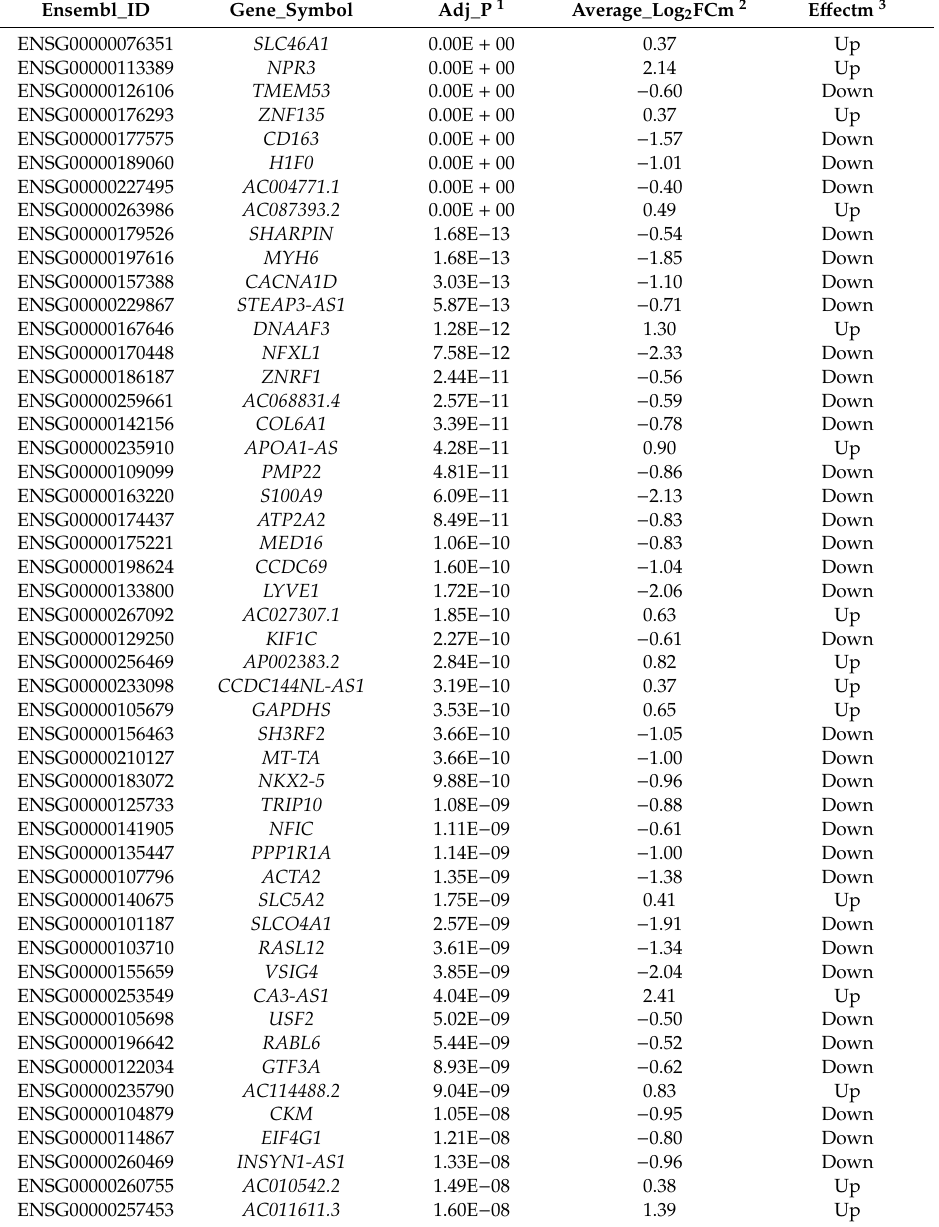
Table 2. Top 50 di ff erential expressed genes identified in meta-analysis of DCM vs.